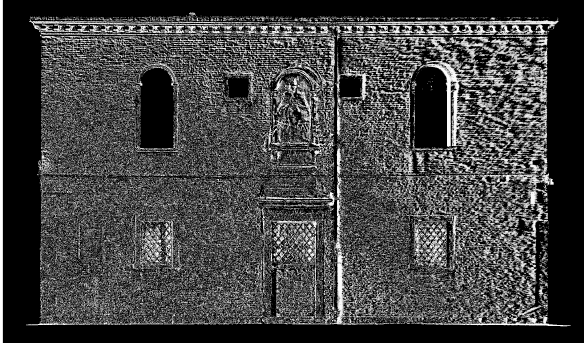
Figure 10. Results of comparison beetween orthophotos Finally, after tests carried out on the front of the School of Varoteri, we can say that in the case of medium to large buildings the software Arc3D can be effectively used for the restitution of